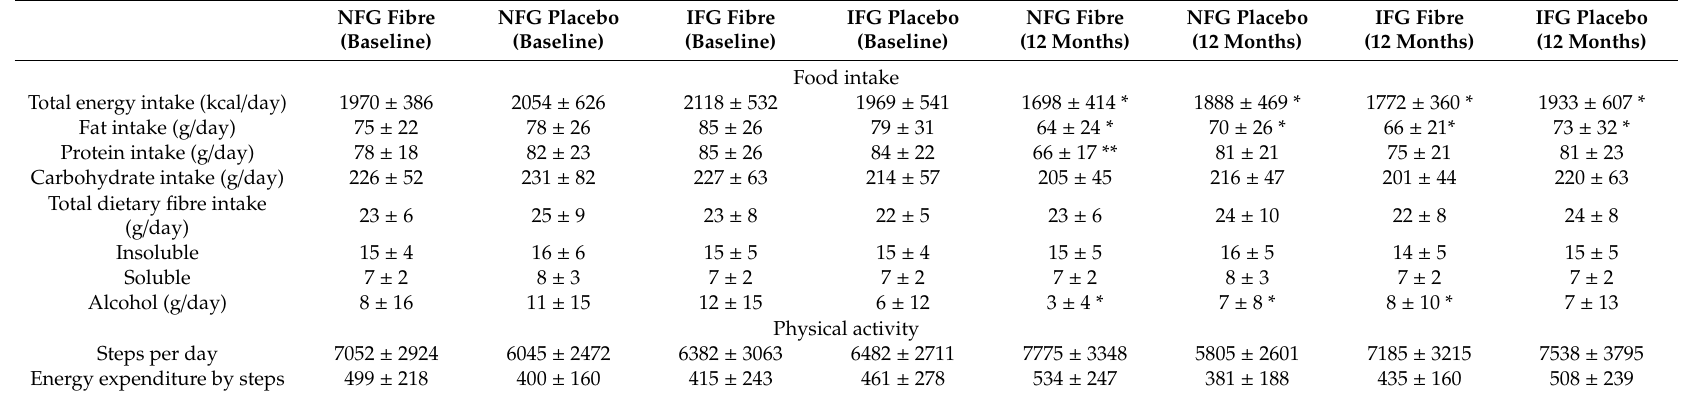
Table 3. Lifestyle habits at baseline and after one year of